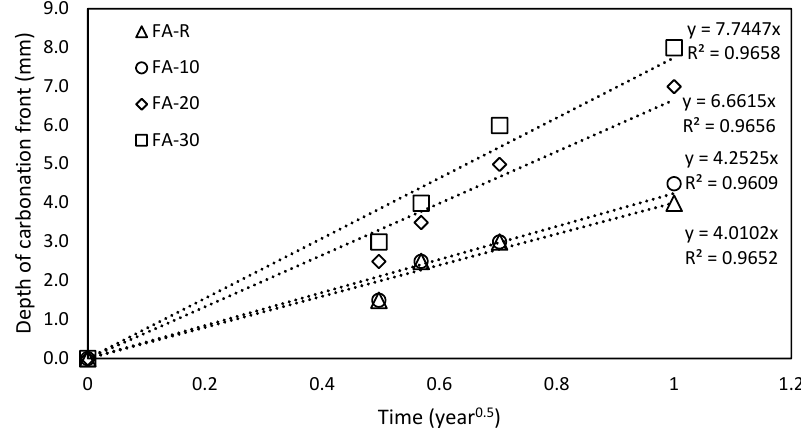
Figure 15. Calculated values of the durability index for single mixtures.